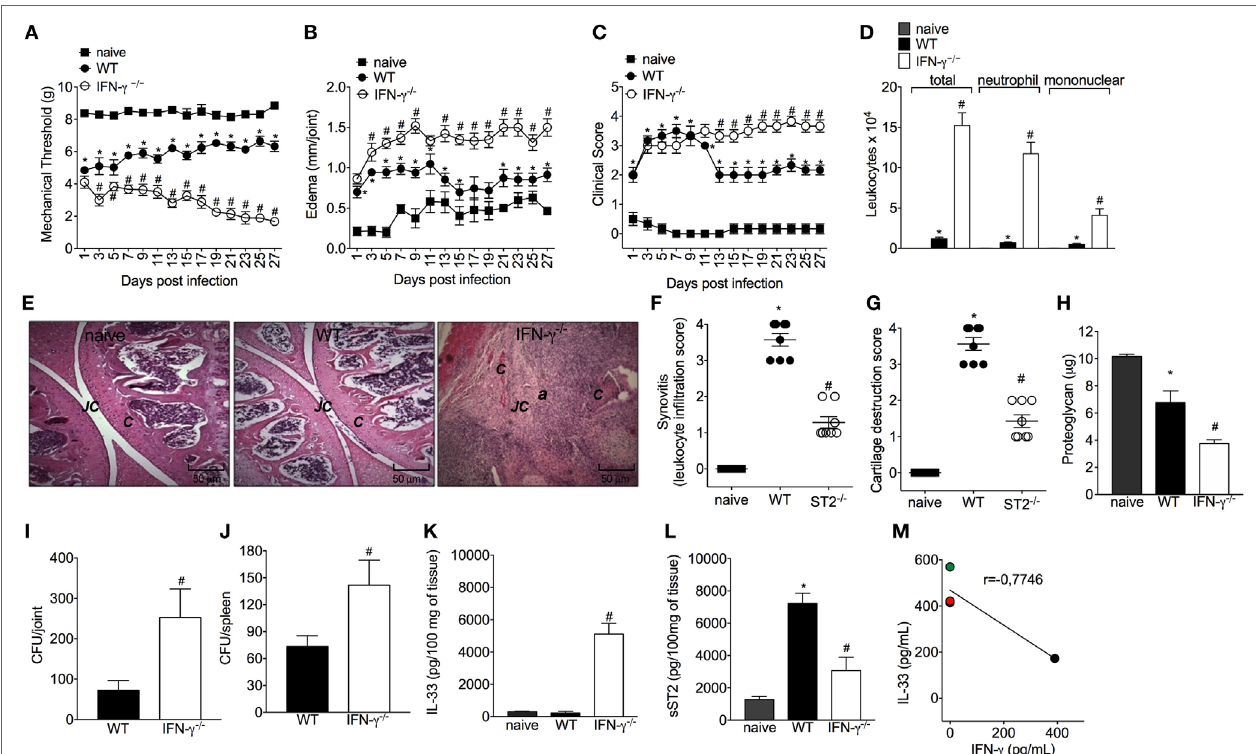
FigUre 6 | Interferon- γ (IFN- γ ) contributes to the resolution of staphylococcal arthritis. Staphylococcus aureus or saline was injected in in the femur-tibial joint of wild-type (WT) and IFN- γ − / − mice. (a) Mechanical hyperalgesia, (B) articular edema, and (c) clinical score were evaluated over 27 days post-infection. At 28-day post-infection, knee joint samples were collected at 28-day post-infection to determine: (D) leukocyte recruitment to the articular cavity, histopathological analysis of hematoxylin/eosin stained slices: (e) representative images of knee joints at 28 post-infection in original magnification × 10. The letter a indicates a heavily inflamed joint with cartilage destruction and pannus formation, (F) synovitis score (intensity: 1–4), and (g) cartilage destruction score (intensity: 1–4). At 28-day post-infection, (h) proteoglycan content in patellas, (i) bacterial counts in knee joint cavity, (J) and were determined, and (K) interleukin-33 (IL-33) and (l) sST2 concentrations in knee joints were determined by ELISA. Correlation analysis of IL-33 and IFN- γ levels determined by ELISA in synovial fluid samples from patients with septic arthritis. For inflammatory parameters and proteoglycan content: n = 6 per group per in vivo experiment, representative of two independent experiments. * P < 0.05 vs naïve mice group, # P < 0.05 vs WT mice group (a–D,h–l) . One-way ANOVA followed by Tukey’s test. For histological analysis: n = 8 per group per experiment, representative of two independent experiments. * P < 0.05 vs naïve mice group, # P < 0.05 vs WT mice group (e–g) . Kruskal–Wallis test followed by Dunn’s test. Spearman rank correlation test was used for the assessment of correlation (M) . Abbreviations: C , cartilage; JC, joint